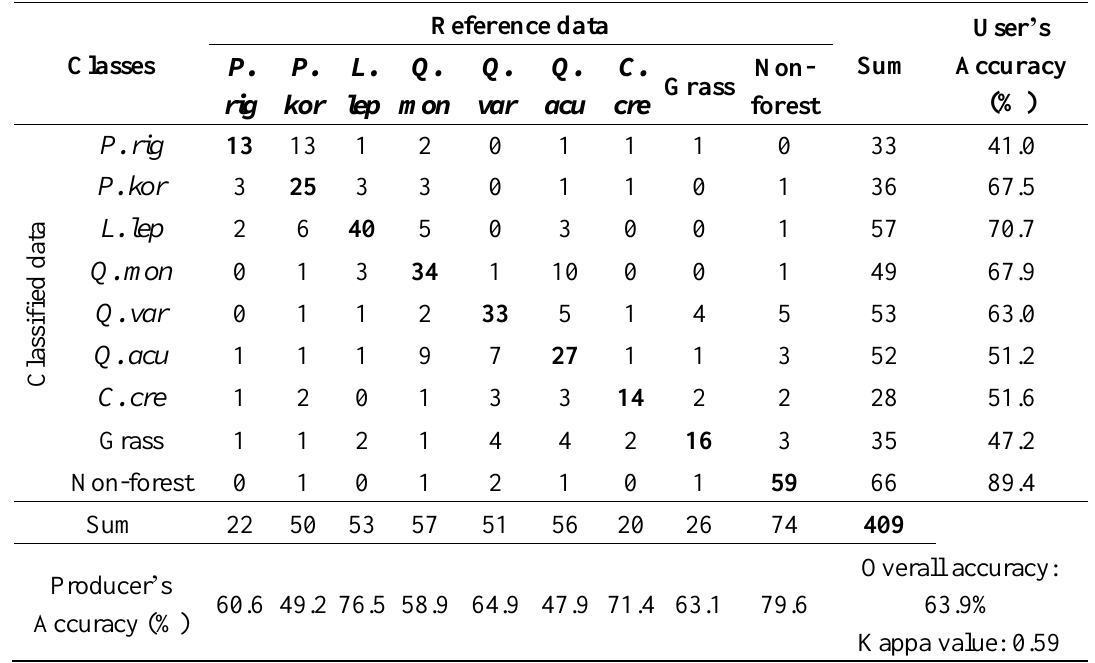
Table 3. Error matrix of the pixel-based classification (PBC) using a maximum likelihood method.